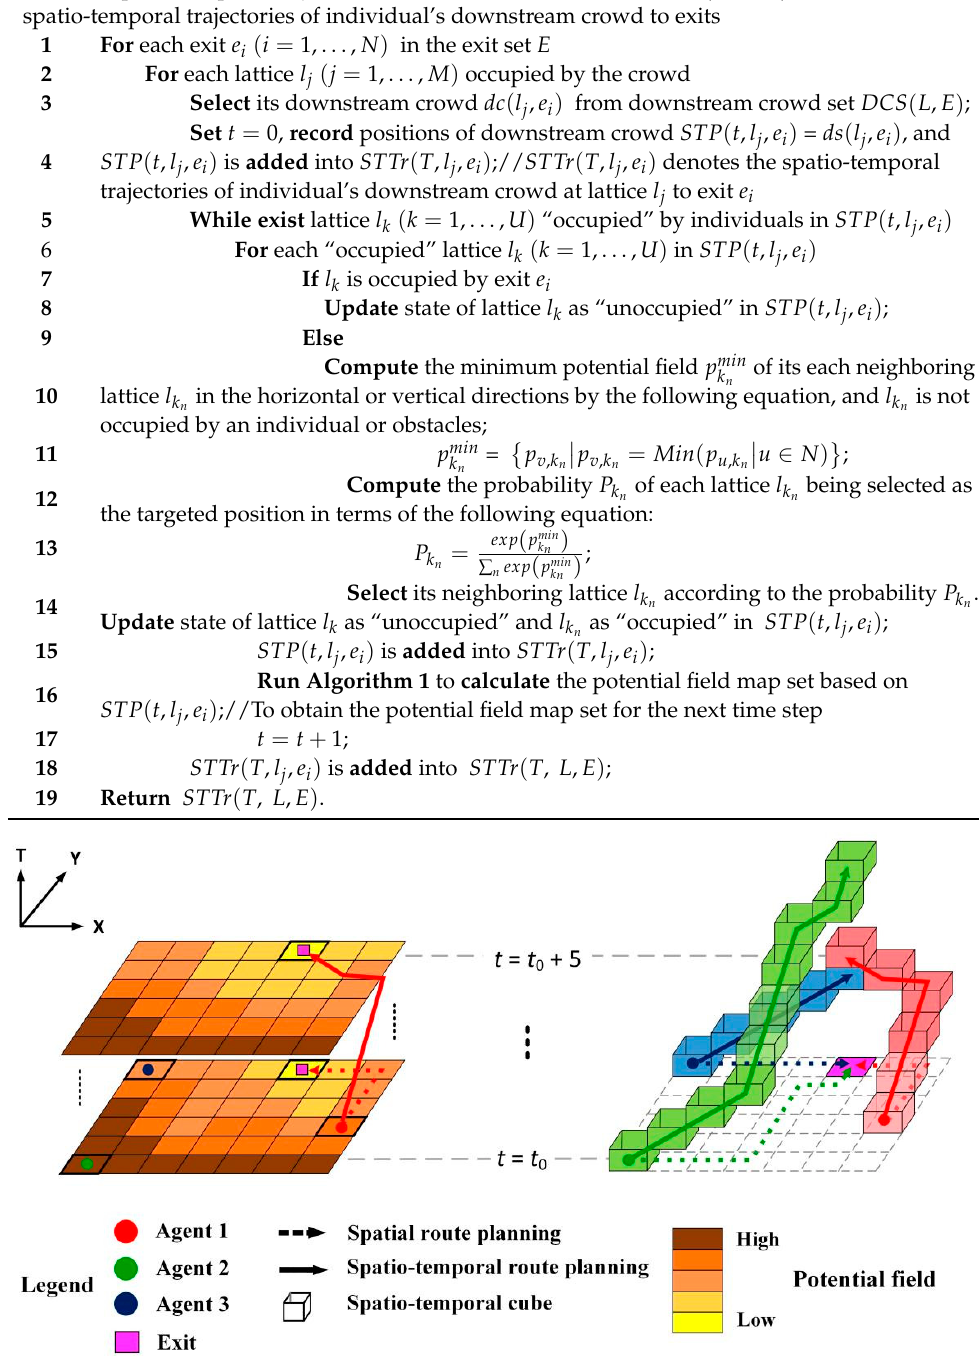
Figure 2. Individual spatio-temporal route planning based on spatio-temporal potential field map.